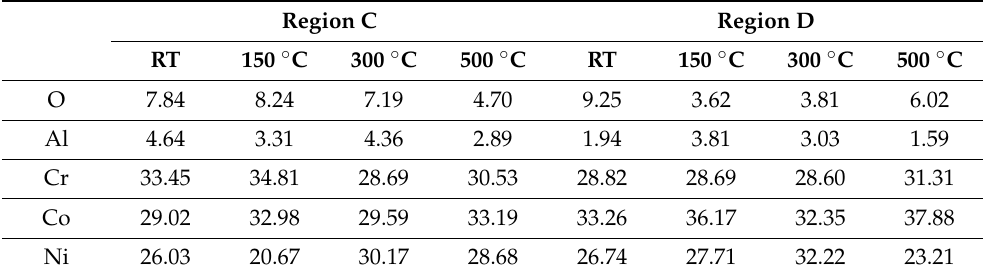
Table 3. Proportion of different elements near TGO/BC interface at different temperatures (wt.%).